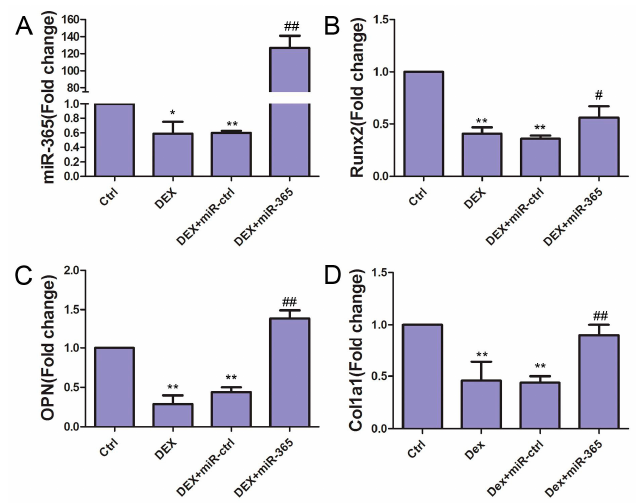
Figure 3. MiR-365 over-expression attenuated the suppressive effect of DEX on osteogenic gene expression in MC3T3-E1 cells. qPCR revealed that the mRNA expressions of miR-365 ( A ), Runx2 ( B ), OPN ( C ), and Col1a1 ( D ) in MC3T3-E1 cells were suppressed by DEX treatment while miR-365 over-expression rescued such suppression. n = 3.* p < 0.05, ** p < 0.01 compared to control; # p < 0.05, ## p < 0.01 compared to DEX+miR-ctrl.